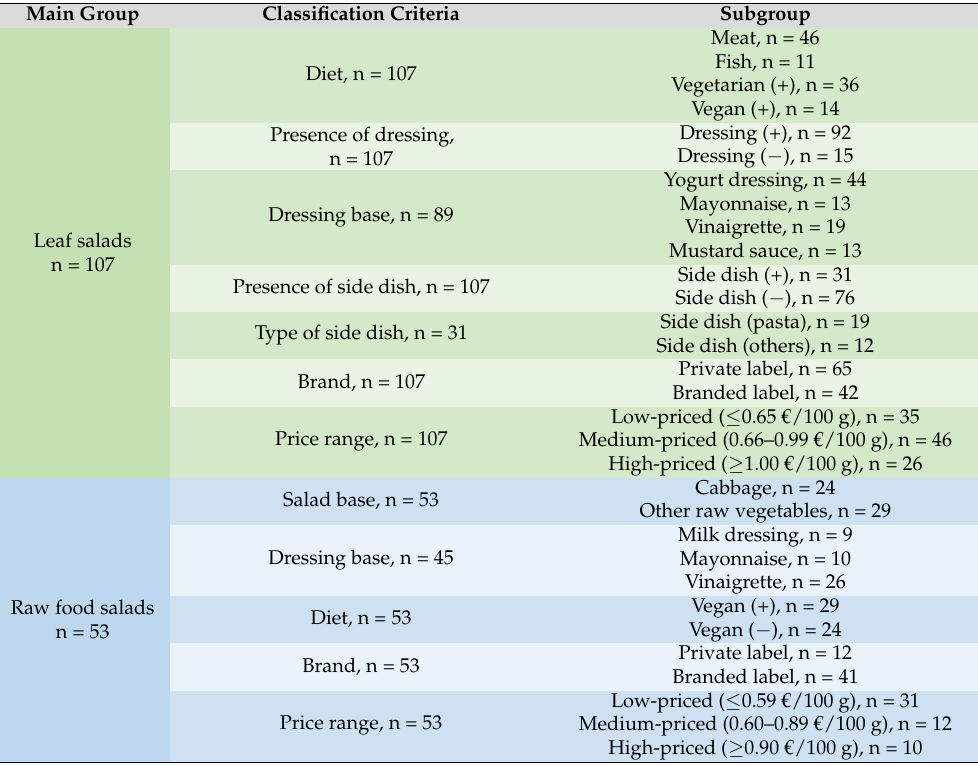
Table 1. Classification of the recorded salads (n = 294) into main groups and